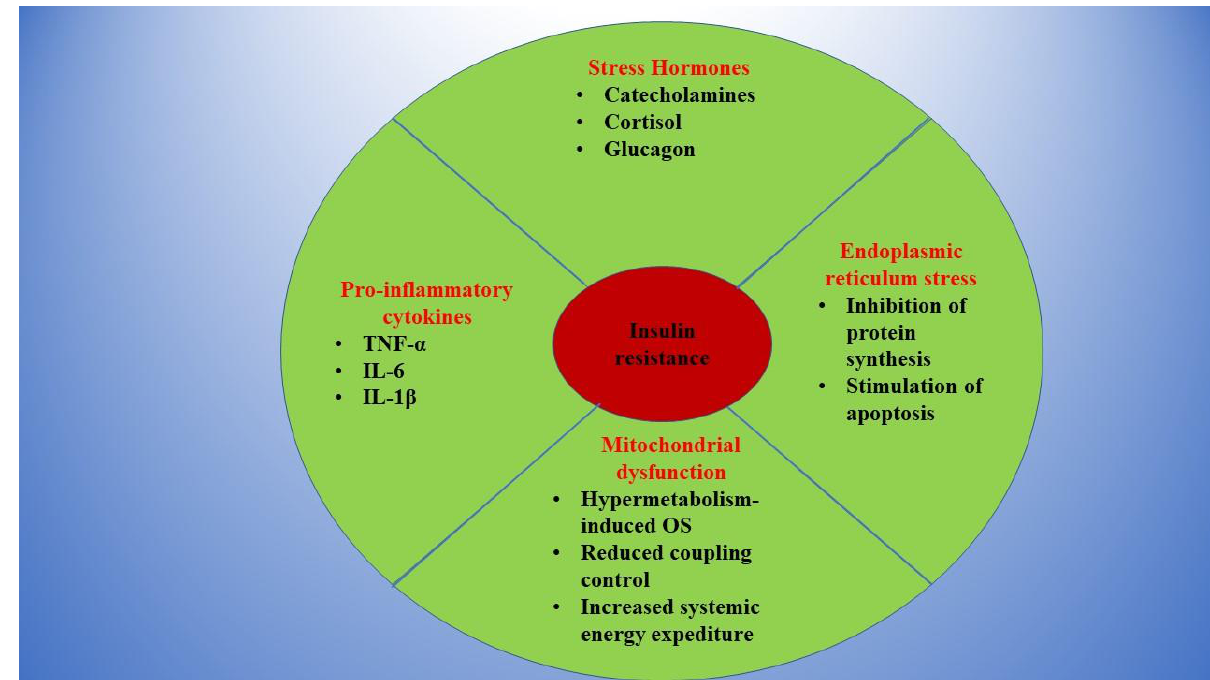
Figure 1. The main contributors to insulin resistance in burns.